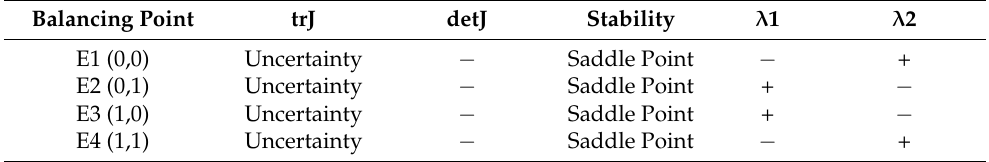
Table 5. Asymptotic stability analysis of the local equilibrium points under Scenario